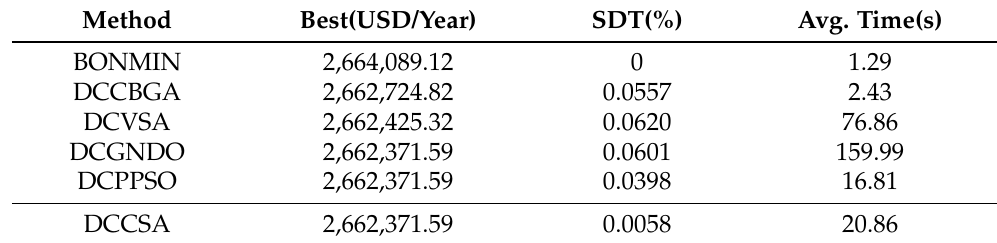
Table 4. Numerical performance comparison in the 33-bus feeder after 100 consecutive